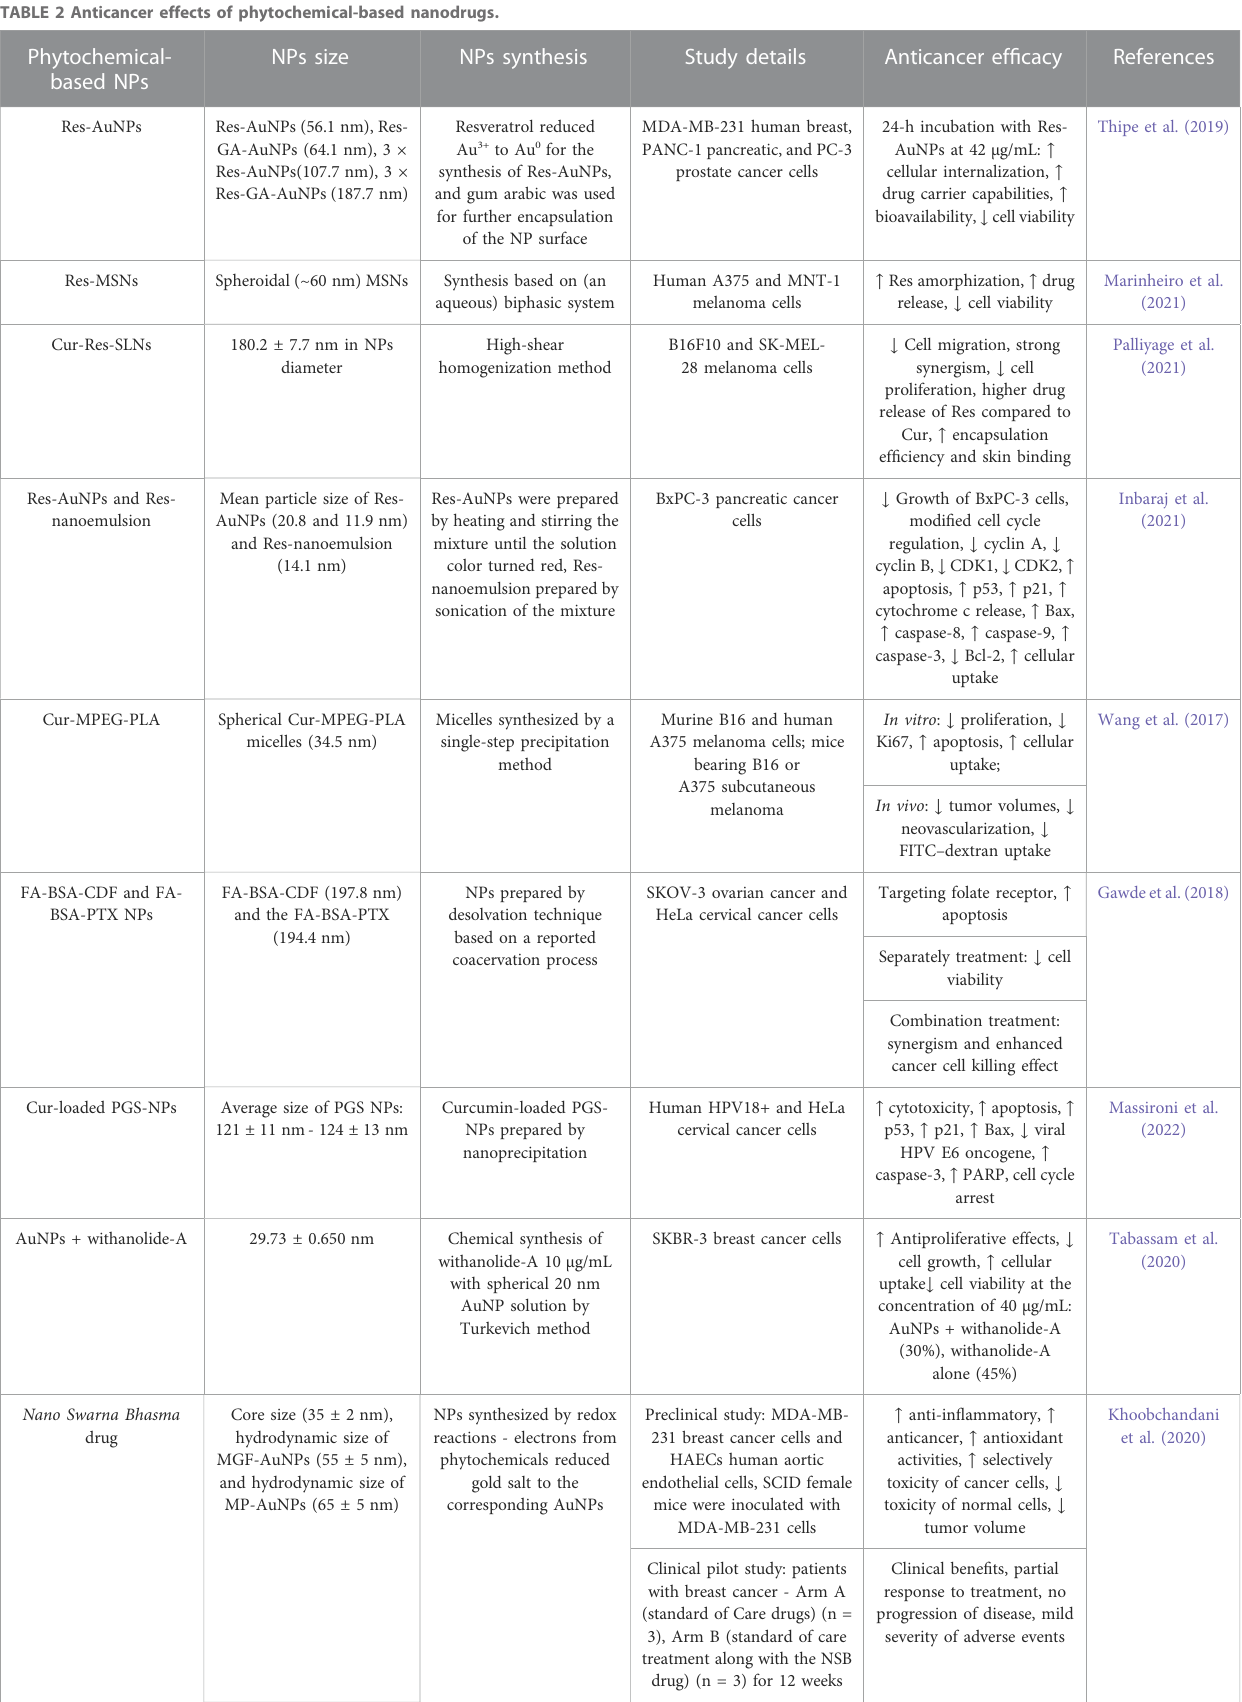
TABLE 2 Anticancer effects of phytochemical-based